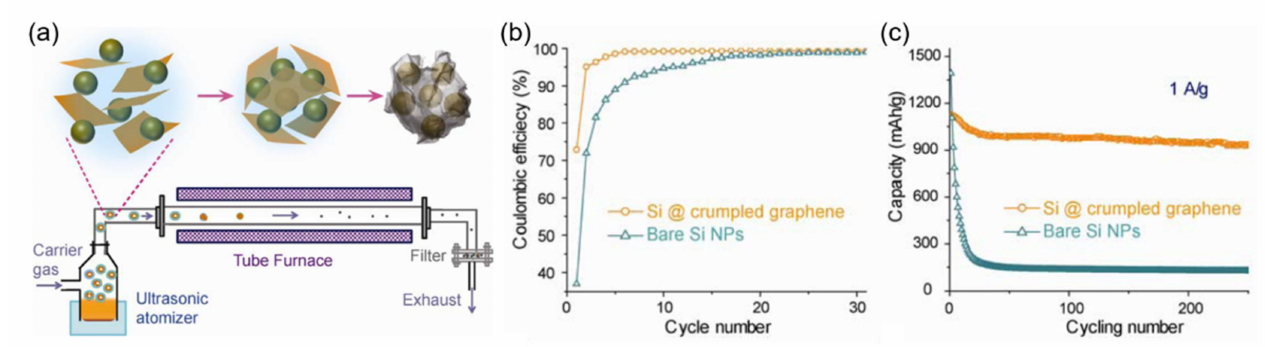
Figure 4. ( a ) Schematic drawing illustrating the synthesis of the crumpled-graphene-wrapped Si nanoparticles. ( b ) Coulombic efficiency of the Si@crumpled graphene compared to the bare Si nanoparticles. ( c ) Charge/discharge cycling data of the Si@crumpled graphene compared to the bare Si nanoparticles. Reproduced with permission from ref. [56]. Copyright 2012, ACS